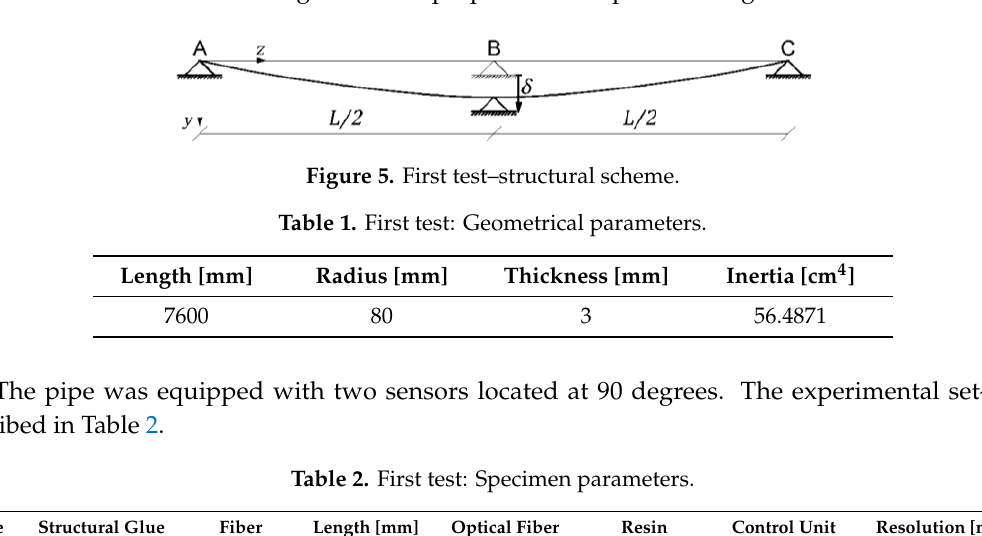
Table 1. First test: Geometrical parameters.